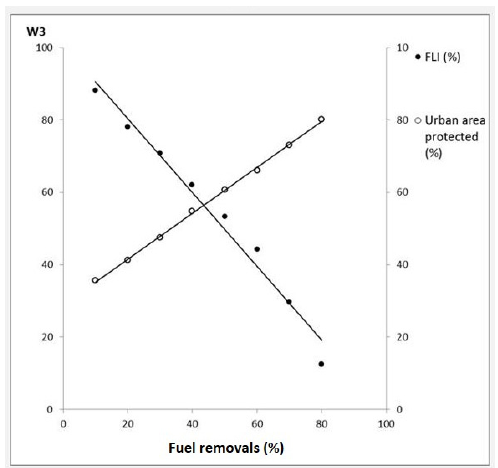
Figure 2. Effectiveness analysis of fuel removal in three different wind direction scenarios (W1, W2 and W3). The line-line intersections represent the percentage of fuel load removal needed to determine the lowest cost per hectare of unaffected wildland-urban interfaces (WUIs) threatened by wildfires.